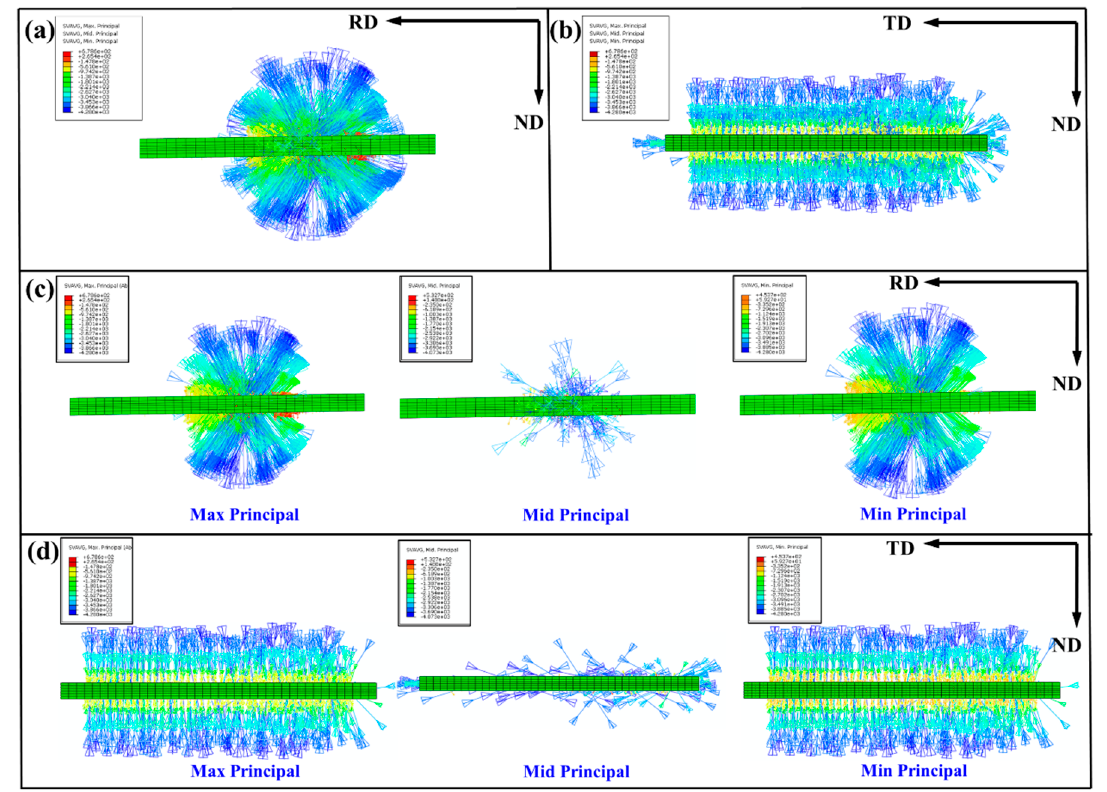
Figure 10. Analysis of max principal, mid principal, and min principal of RR50% on the ( a , c ) RD-ND plane and ( b , d ) TD-ND plane.